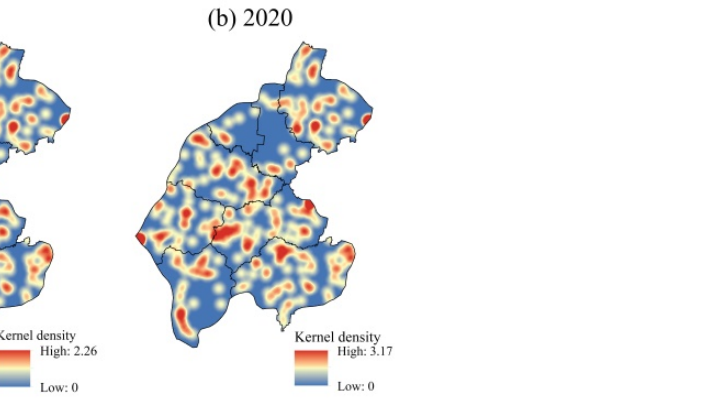
Figure 6. The distribution of kernel density in Pingyin County from 2010 to 2020. ( a ) 2010; ( b ) 2020.